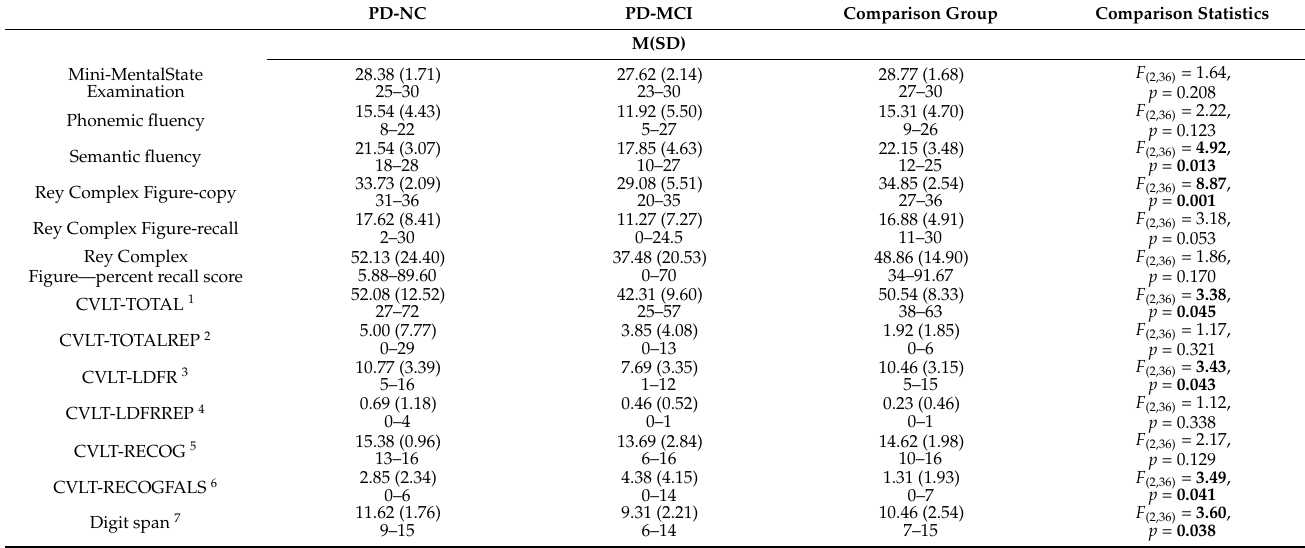
Table 3. Additional information on cognitive functioning in division into 3